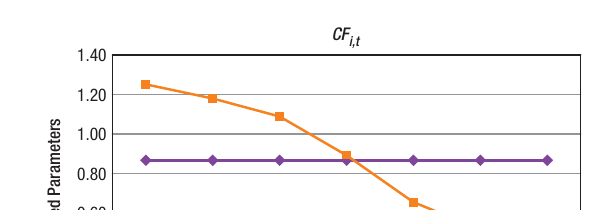
Fig. 1. Estimated parameters of relationship between I Notes: 1. The linear relationship represents OLS regression. 2. The non-linear relationship represents quantile regressions